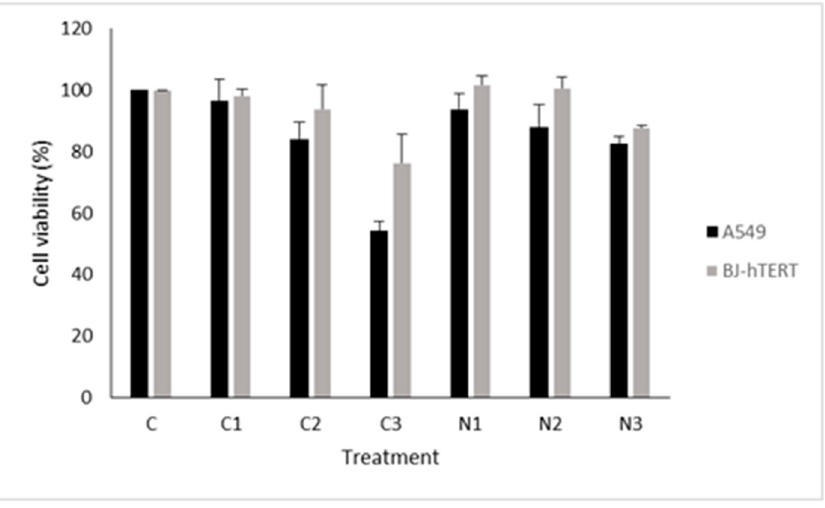
Figure 5. Cell viability for Ci and Ni formulations in A549 cancer cells and healthy BJ-hTERT cells. C is designated as the control, and it corresponds to cells without treatment.